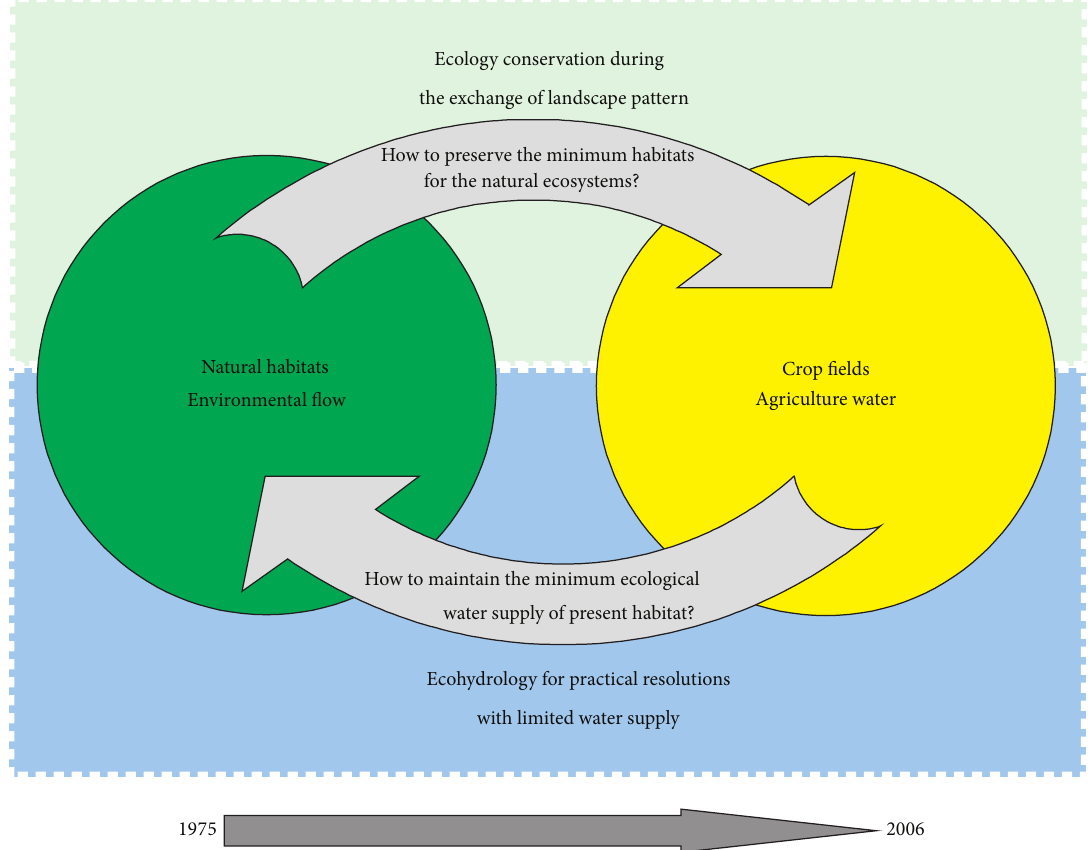
Figure 4: Two key issues in wetland eco-hydrology during the regional process of marsh wetland